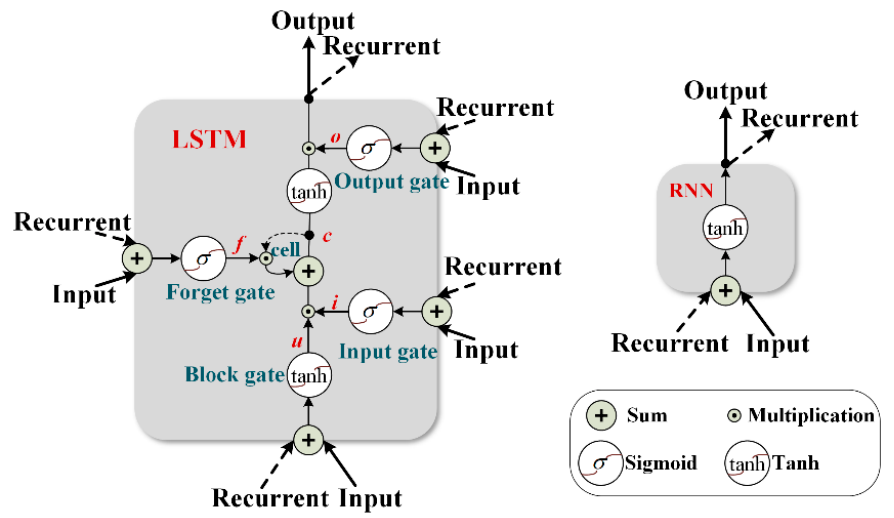
Figure 5. Architectures of LSTM and a general RNN.